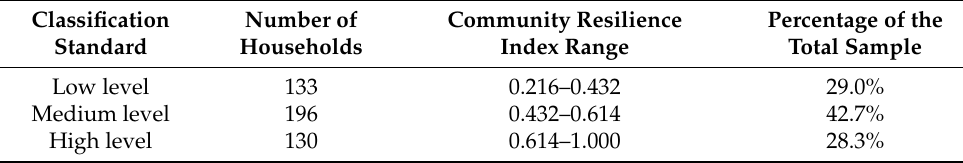
Table 2. Classification of community resilience of relocated